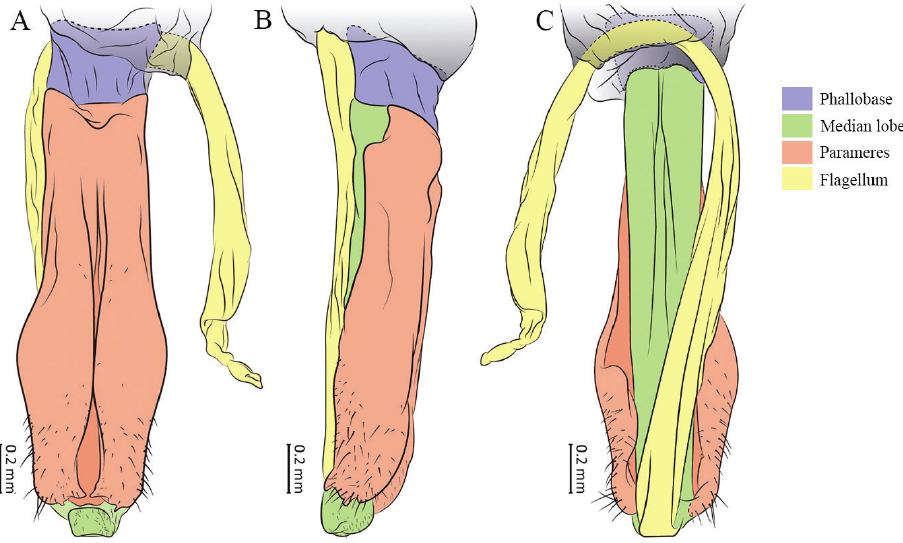
Figure 1. Morphological structures in the male reproductive apparatus of Cenophengus gardunoi sp. nov. A dorsal view B lateral view C ventral